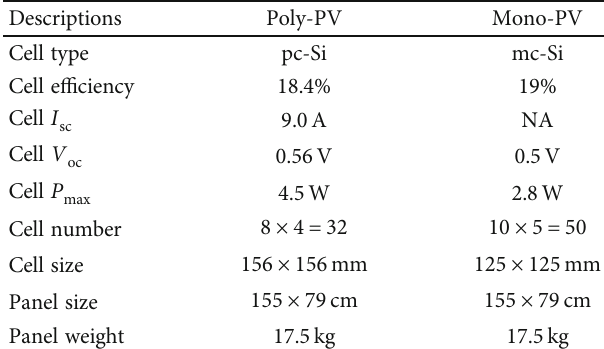
Table 2: Speci fi cation of the panels.